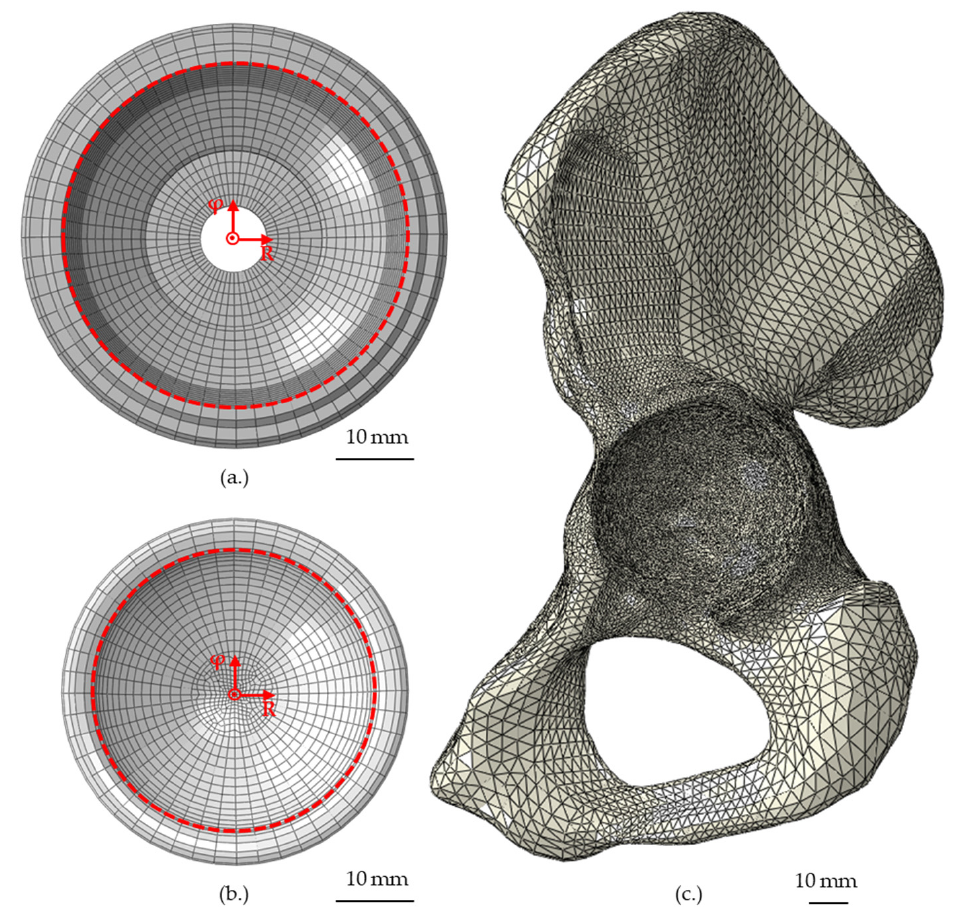
Figure 2. Depiction of the node paths at the inner rim of the shell ( a ) and liner ( b ), consisting of 62 and 47 nodes, to analyze the radial deformation in polar coordinate systems. Moreover, the analyzed node region in terms of strain distribution at the surface of the hemi-pelvis is depicted ( c ).